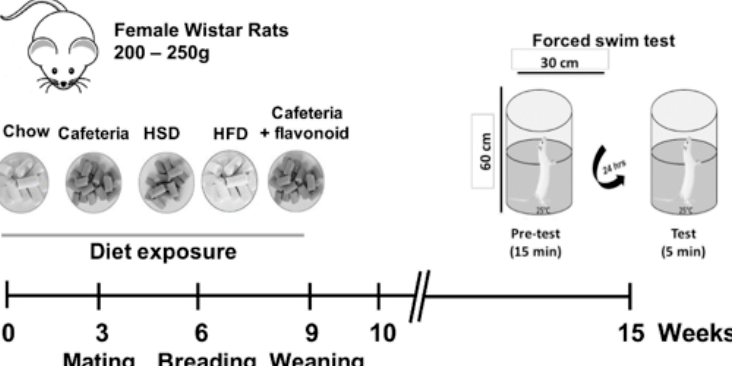
Figure 1. Nutritional programming schedule. Females were exposed to Chow, cafeteria, HSD, HFD, or cafeteria + flavonoids for 9 weeks, as described in Material and Methods. Depression-like behaviour was evaluated by the forced swim test.